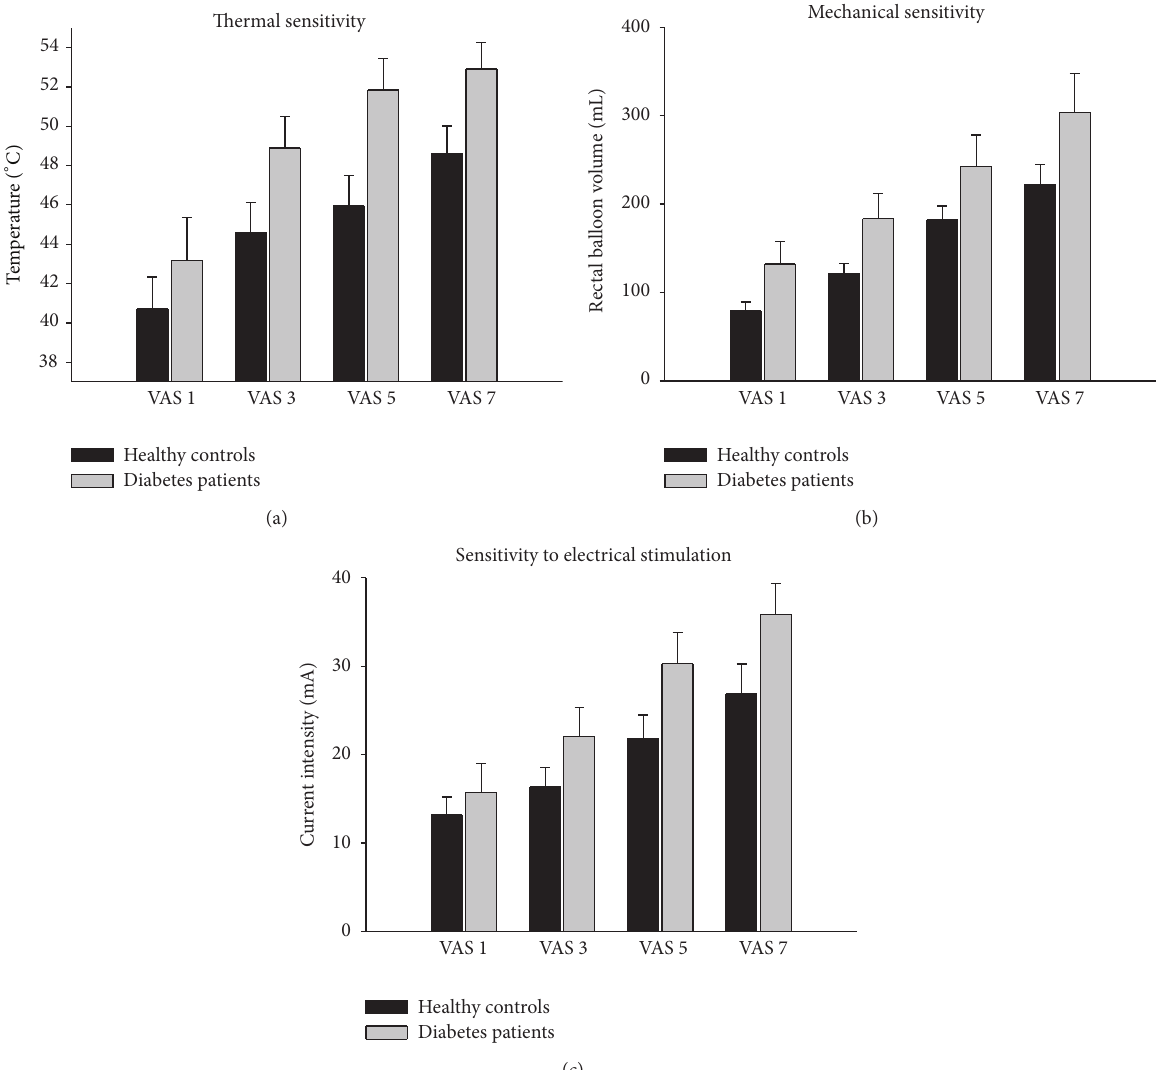
Figure 1: (a) The rectal sensitivity to thermal stimulation. Patients showed overall hyposensitivity to heat ( 𝐹 = 12.8 , 𝑃 < 0.001 ). The 𝑌 - axis describes the actual balloon temperature needed to induce the sensation corresponding to VAS ratings. Error bars represent SEM. (b) The rectal sensitivity to mechanical stimulation. Patients showed overall hyposensitivity to mechanical distension ( 𝐹 = 11.9 , 𝑃 < 0.001 ). The 𝑌 -axis describes the rectal balloon volumes needed to induce the corresponding VAS ratings. Error bars represent SEM. (c) The rectal sensitivity to electrical stimulation. Patients showed overall hyposensitivity to electrical stimulation ( 𝐹 = 8.8 , 𝑃 < 0.004 ). The 𝑌 -axis describes the current intensity needed to induce the corresponding VAS scores. Error bars represent